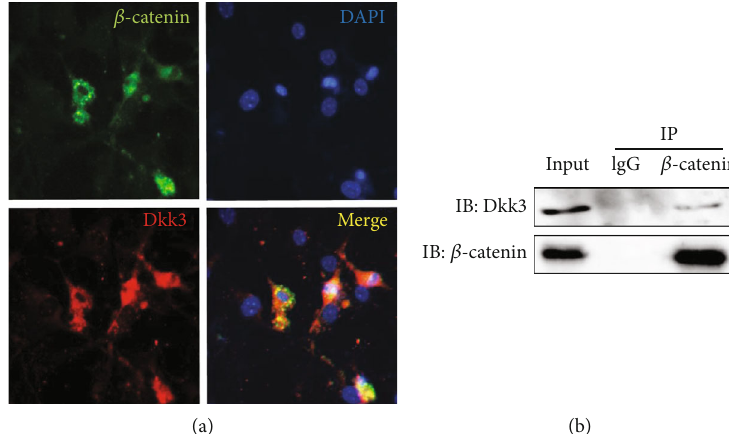
Figure 9: The interaction of Dkk3 and β -catenin. (a) Immuno fl uorescent localization showed the overlapping area of β -catenin and Dkk3 protein. Scale bars, 25 μ m. (b) Coimmunoprecipitation using anti-IgG (negative control) and anti- β -catenin showing interaction of Dkk3 with β -catenin in C3H10T1/2 cells. All assays were repeated at least three times. Data were shown as means ± SD ( n = 3 ).